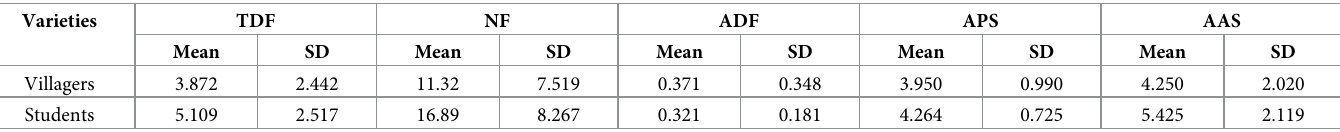
Table 2. Mean value of eye movement indicators of villagers and students as a whole.